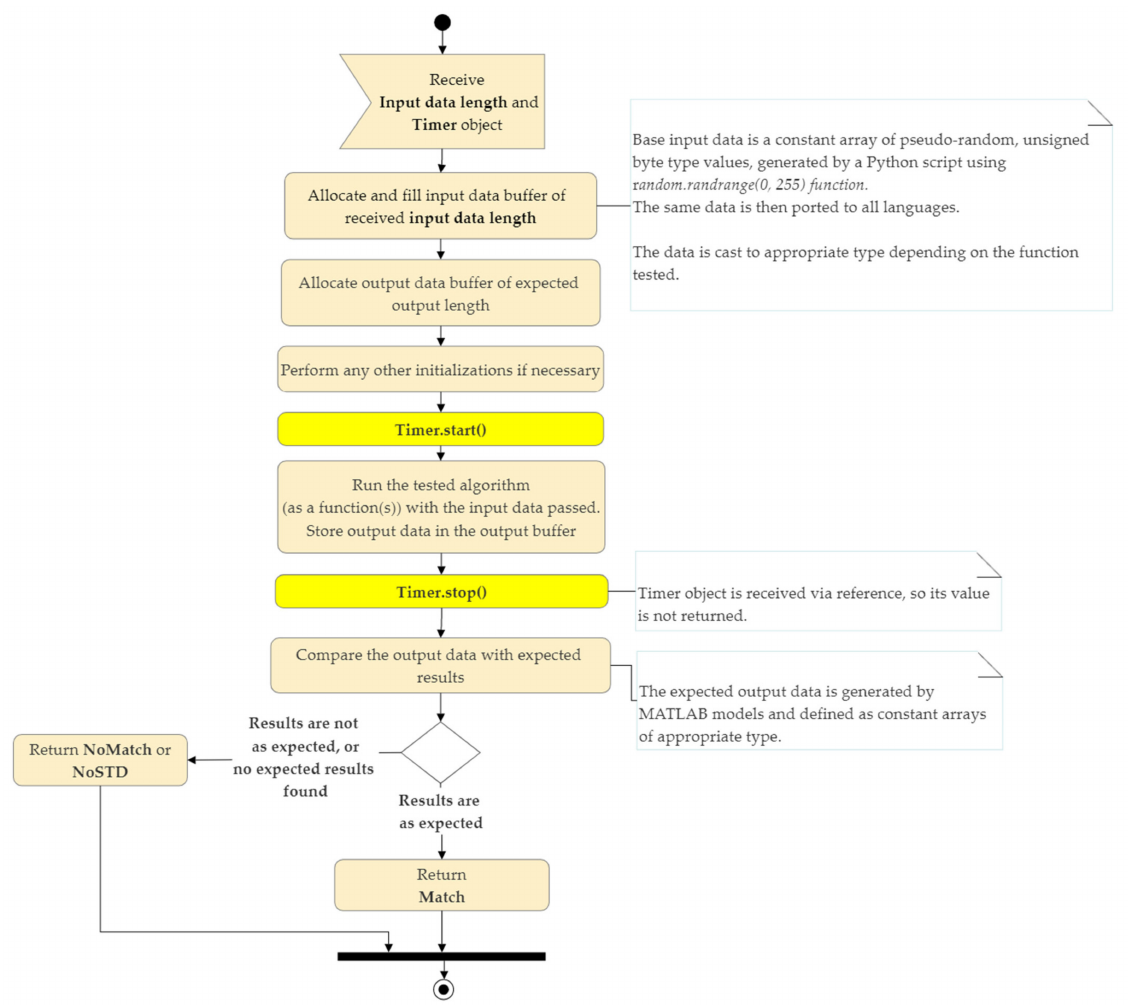
Figure 1. The algorithm of the execution time measurement